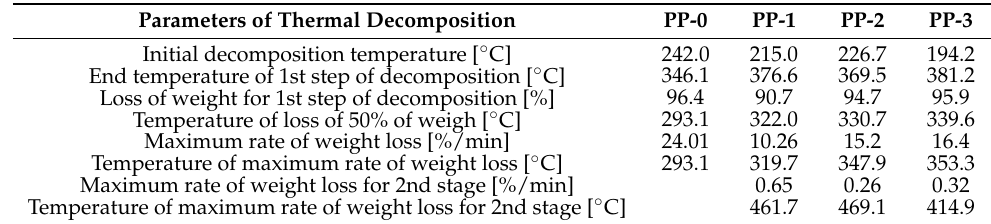
Table 1. The most important parameters for the thermal decomposition process for PP-0, PP-1, PP-2, and PP-3